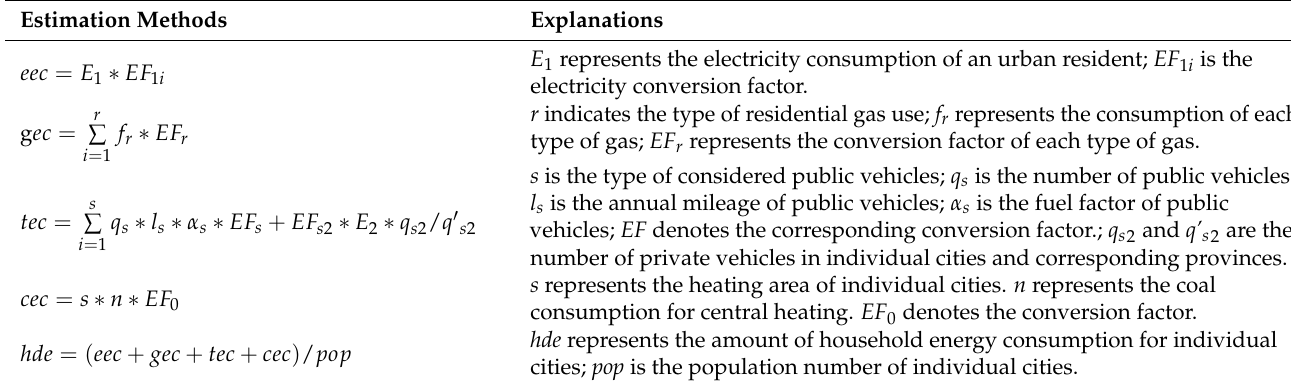
Table 1. Estimation Methods of Urban Household Energy Consumption. Estimation Methods